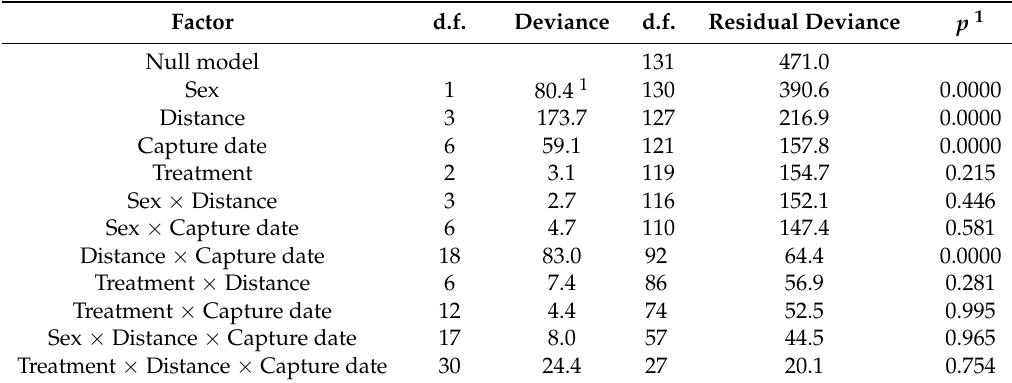
Table 1. Analysis of deviance of Anartia fatima dispersal data from September.